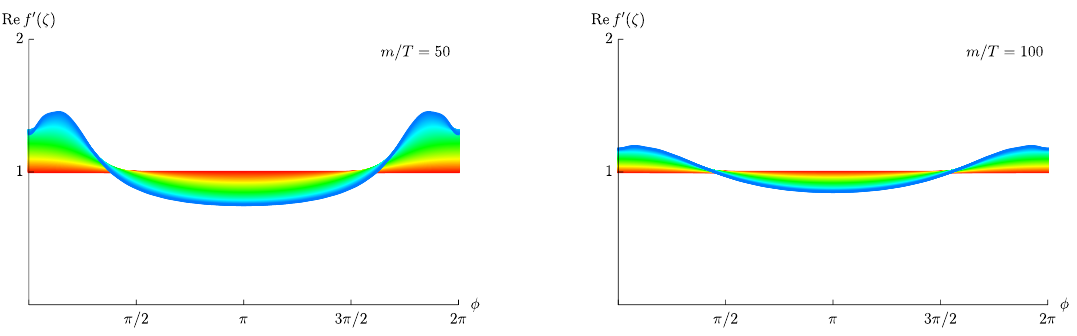
Figure 2 . Plot of the univalence condition Re f 0 ( ζ ) , with ζ = | ζ | e iφ and φ ∈ [0 , 2 π ] , for energy diffusion in the linear axion model at two different values of m/T : m/T = 50 ( left panel ) and m/T = 100 ( right panel ). In each case, the colour gradient indicates different | ζ | , from | ζ | = 0 in red to | ζ | = 1 (corresponding to | z | = R ) in blue. The function f ( ζ ) follows from a map of the dispersion relation ω ( z ) which is obtained by a polynomial fit of order 40 to the numerically computed quasinormal mode